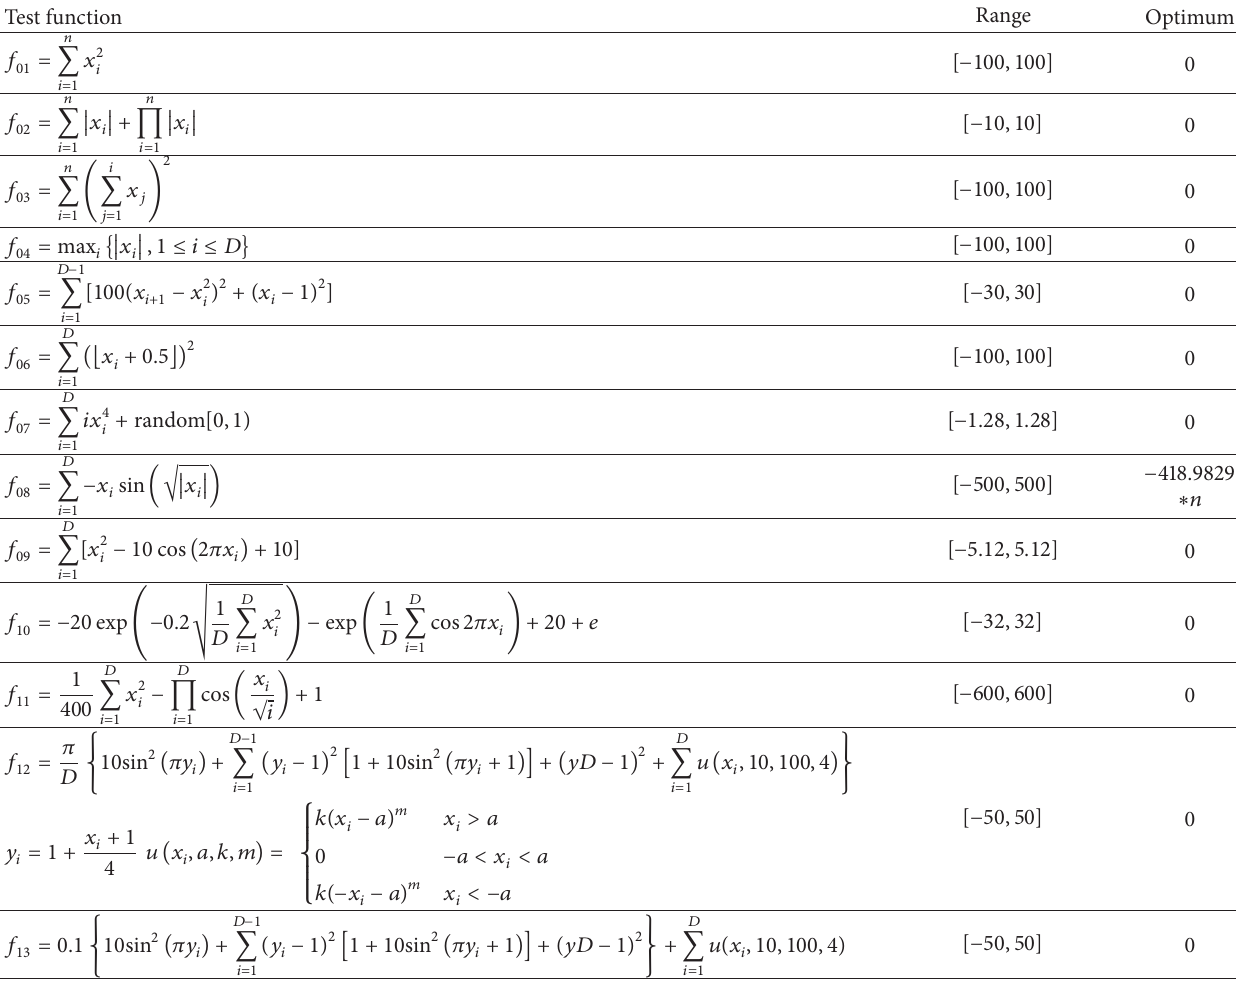
Table 1: Benchmark functions based on our experimental study for